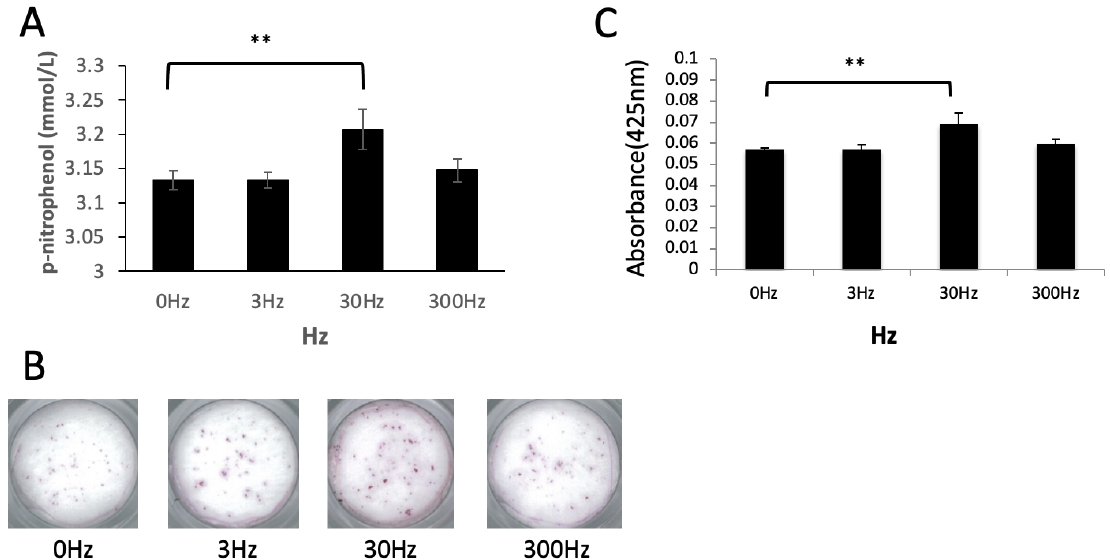
Figure 4. ALP activity and Alizarin Red staining. ( A ): Alkaline phosphatase (ALP) activity, ( B ): Alizarin Red staining, ( C ): Alizarin Red staining intensity. In ( A , C ), ALP activity and calcium deposition were significantly increased at 30 Hz rather than at 0 Hz. Dunnet’s multiple comparison test for 30 Hz and 300 Hz to 0 Hz (**: p < 0.01).